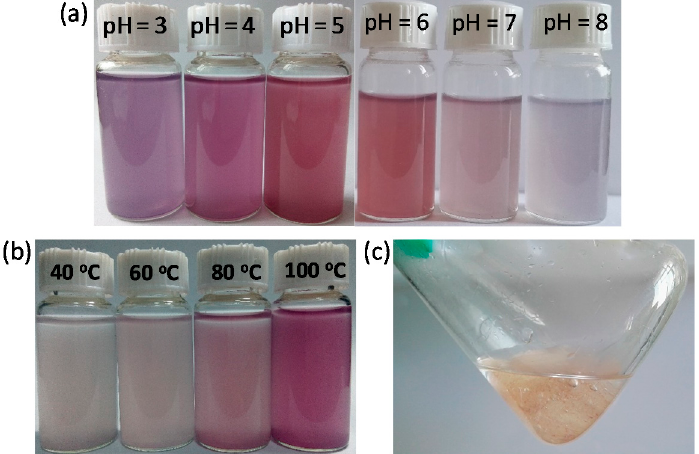
Figure 8. Photographs of AuNP-WP solutions obtained ( a ) at different pH values and ( b ) at different temperatures; and ( c ) photograph of solution containing wool fiber and Au ions after being heated 2 h. The concentration of Au ions was kept as 0.4 mM.